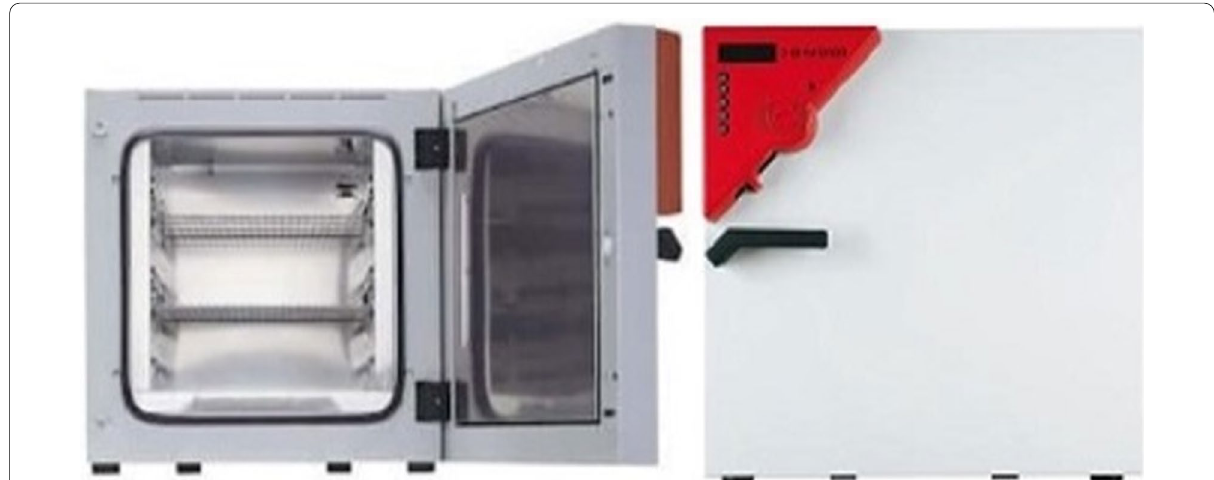
Fig. 2 The Binder FED 53‑UL Forced Convection Drying Oven electronically controlled APT.line ™ preheating